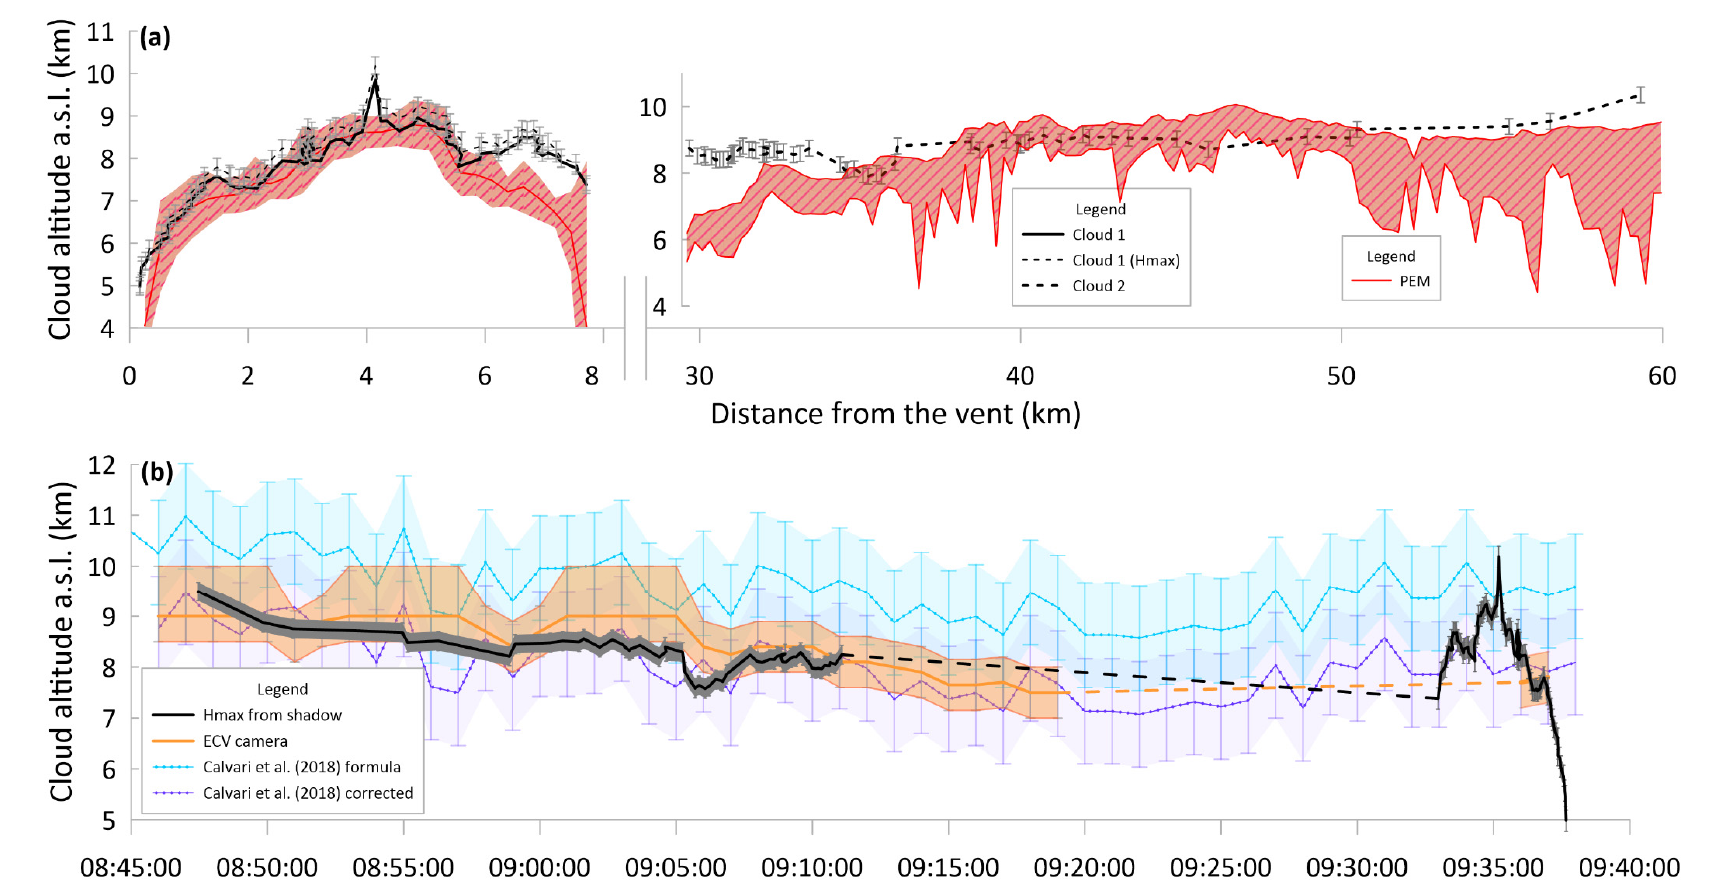
Figure 9. ( a ) Comparison between cloud 1 and cloud 2 ′ s altitude with distance from the vent obtained using the shadow technique and PEM methods. ( b ) Comparison of cloud altitude time series obtained from the OLI images using the shadow technique, ECV camera and from applying Calvari et al.’s (2018) MDR versus height relation [28]. Dashed lines are extrapolated across times for which there are no data under the assumption of plume height stability under stable MDR conditions and sustained lava fountain activity.